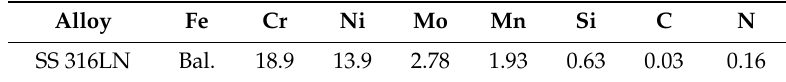
Table 1. Chemical compositions of SS 316LN used in this study analyzed by inductively coupled plasma (ICP) (in wt.%).